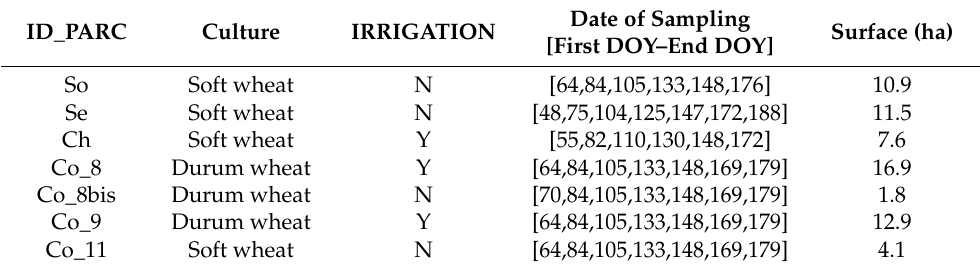
Table 2. Main characteristics of experimental fields.